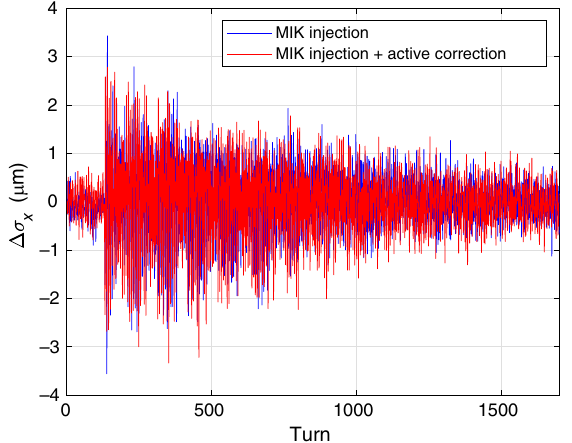
FIG. 15. Variations of the horizontal position of the stored beam due to a single triggering of the MIK, when the active correction is off (blue) and on (red). The slow varying modulation corresponds to synchrotron oscillations. This figure illustrates two processed KALYPSO images.